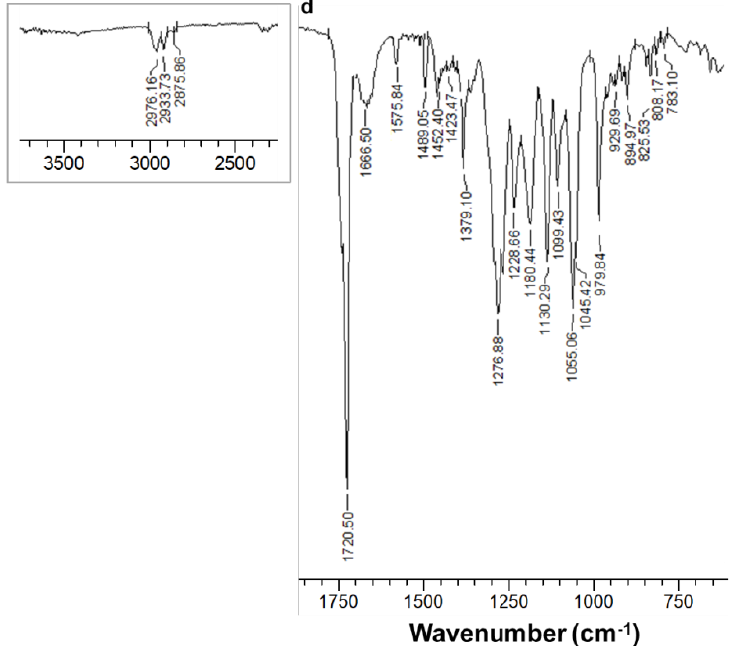
Figure 3. ATR-FTIR spectra of: ( a ) CQ; ( b ) PVP in PHB mat; ( c ) PVP,CQ in PHB mat; and ( d ) PVP,CQ on PHB mat in the range from 1750 to 750 cm − 1 and from 3500 to 2500 cm − 1 (inset).